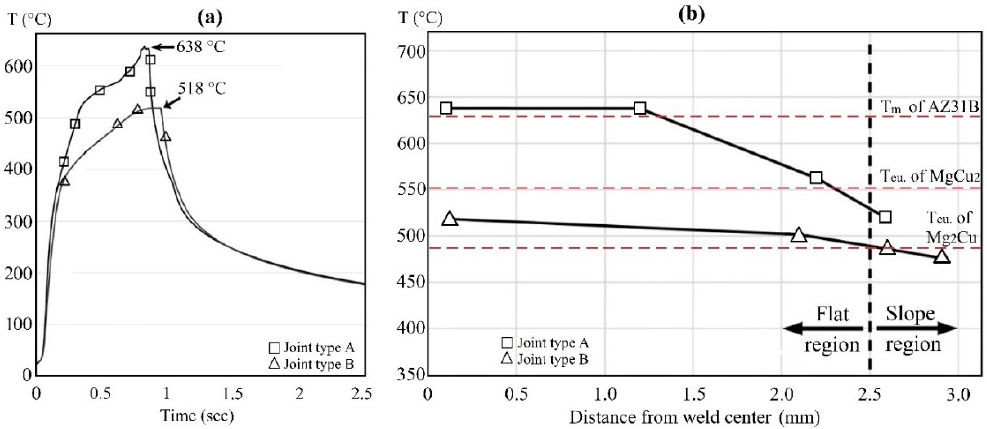
Figure 7. Interface temperature measurements for joint type A (1400 J) and joint type B (1100 J): ( a ) Comparative temperature profile for HP-USW of joint types A and B; ( b ) Maximum temperature of interface in different distances from weld center.